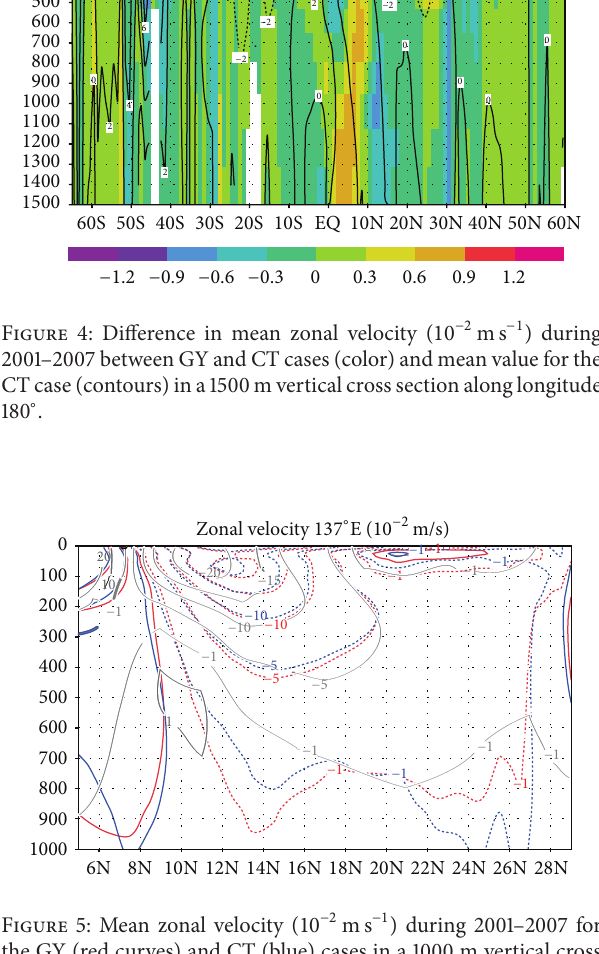
Figure 5: Mean zonal velocity ( 10 −2 ms −1 ) during 2001–2007 for the GY (red curves) and CT (blue) cases in a 1000 m vertical cross section along longitude 137 ∘ E. Gray curves show the climatological geostrophic velocity field calculated by Zhai and Hu